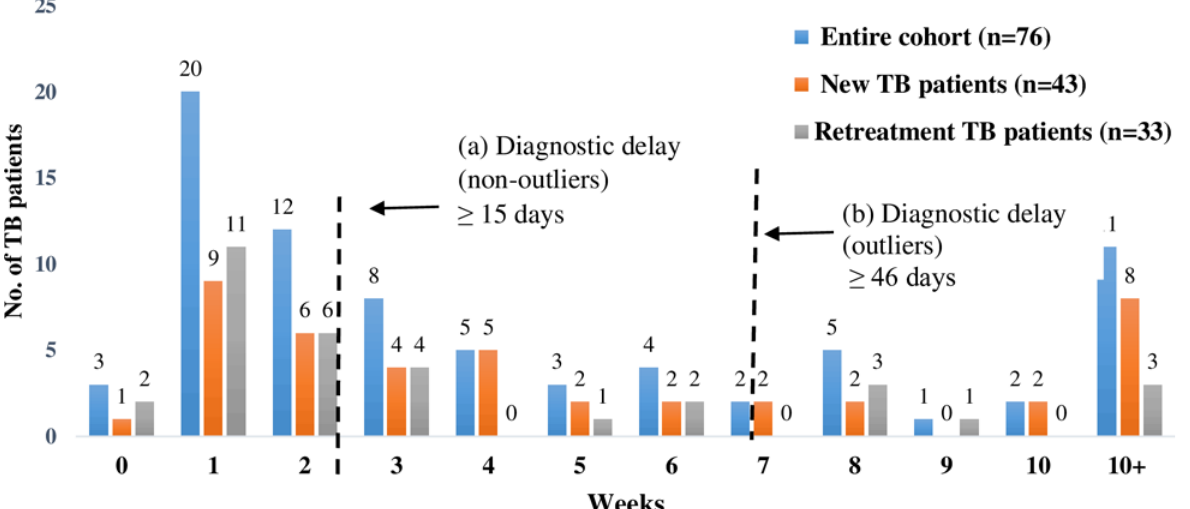
Fig 3. Diagnosis: Duration and Delays. The figure represents the time taken from first contact with any health care provider to receiving PTB diagnosis. The serrated lines depict the durations that reflect (a) delay and (b) outliers.